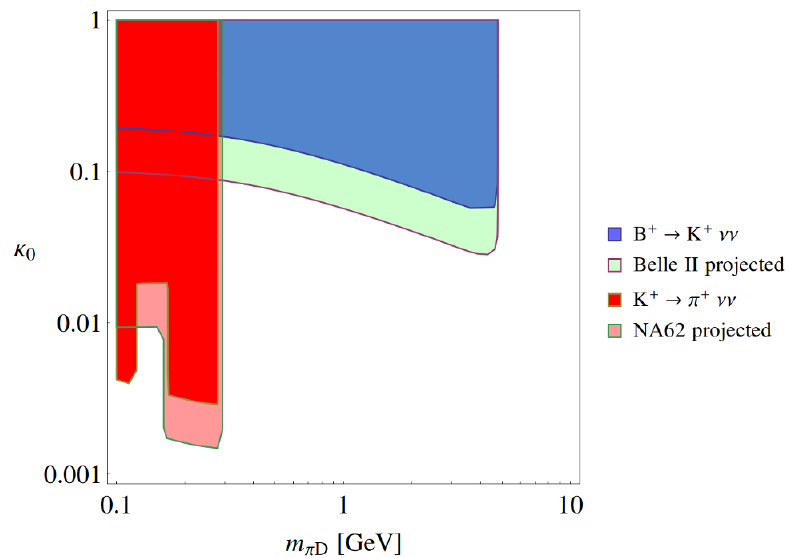
Figure 6. Regions excluded by current limits of semi-invisible meson decays (see table 2) and projected limits from the upcoming Belle II and NA62 experiments, in the \aligned" (cid:13)avour scenario in which (cid:20) = (cid:20) 0 1 3 3 (cid:2)